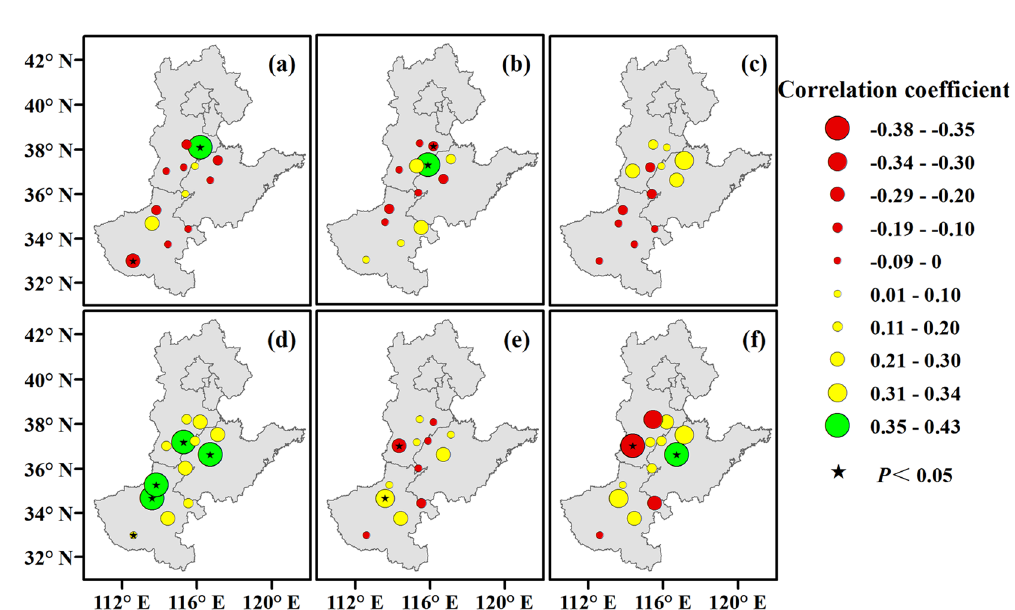
Figure 7. Correlation between rainfall and the lengths of the sowing-emergence ( a ), emergence-squaring ( b ), squaring-flowering ( c ), flowering-boll opening ( d ), and boll opening-harvest ( e ) periods and the whole growing period ( f ) of cotton across the North China Plain from 1981 to 2012. Green, yellow, and red circles represent the correlation coefficient. Black pentagrams represent a significance level of 0.05. Maps were generated using ArcGIS 10.1 (ESRI Inc, Redlands, CA, USA,